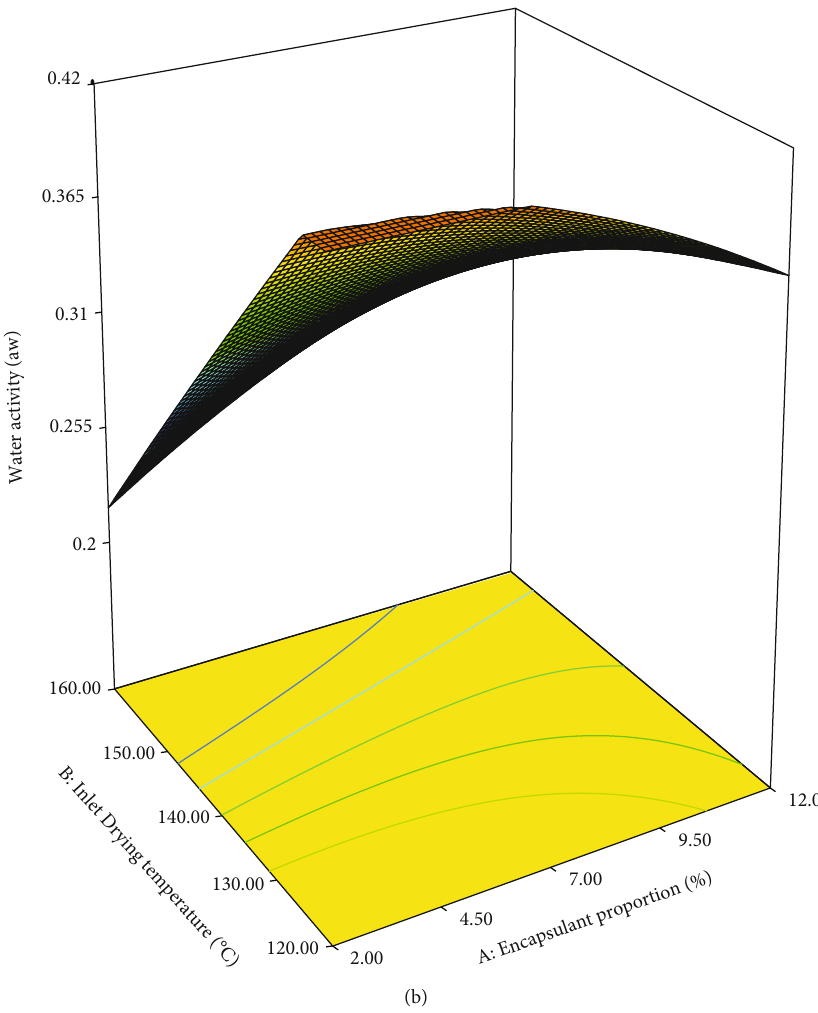
Figure 2: E ff ect of IDT and encapsulant proportion on antioxidant capacity (a) and a